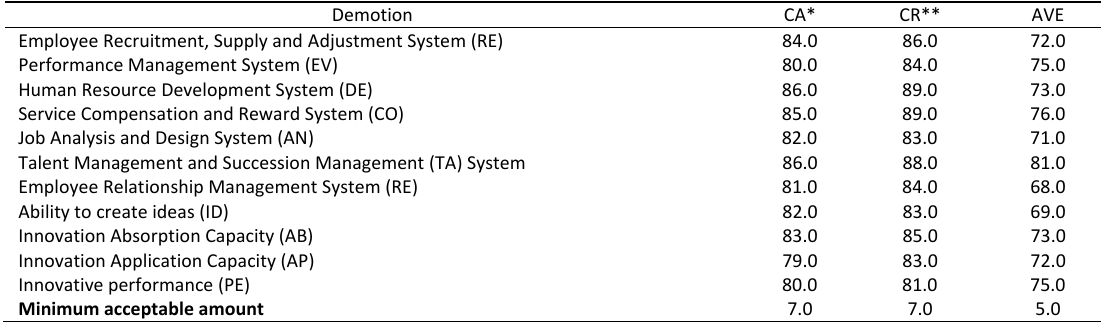
Table 4: Calculated Factor Load Values, Cronbach's Alpha, Combined Reliability and Convergent Validity